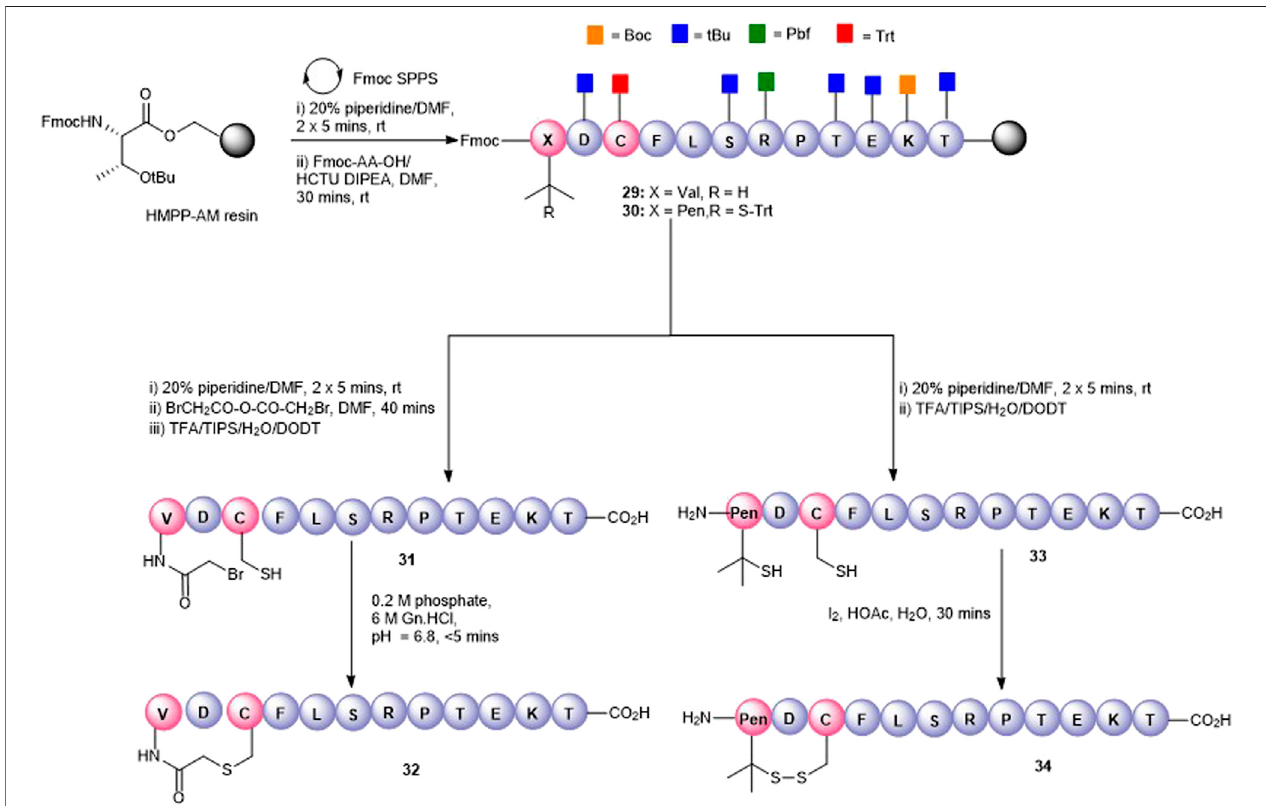
FIGURE 7 | Synthesis of Val1-Cys3 thioester-linked cyclized peptide5 ( 32 ) and a Pen1-Cys3 disul fi de-bonded cyclic peptide5 ( 34 ).